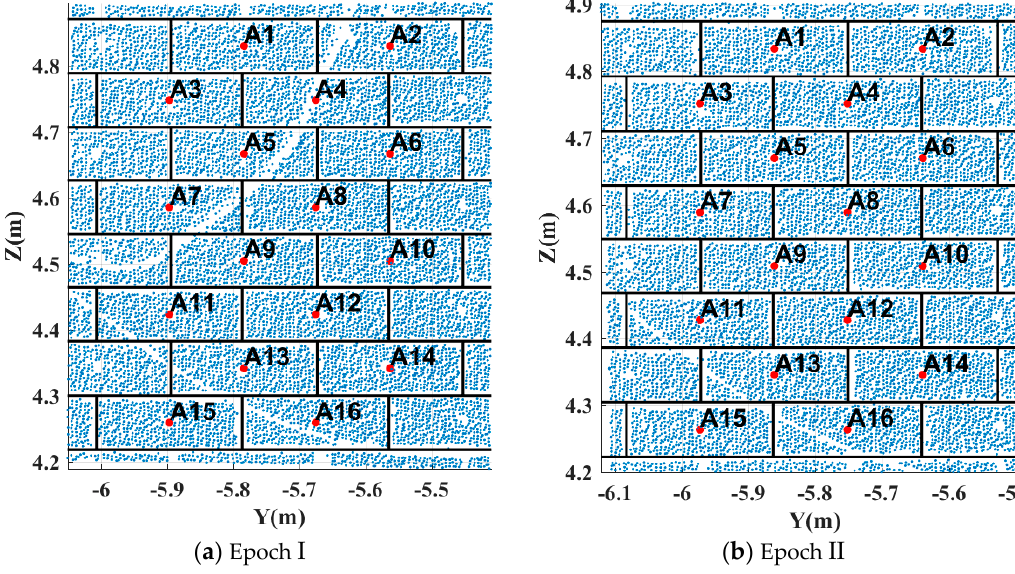
Figure 12. Virtual point extraction results (patch A). The red dots are the final virtual points.